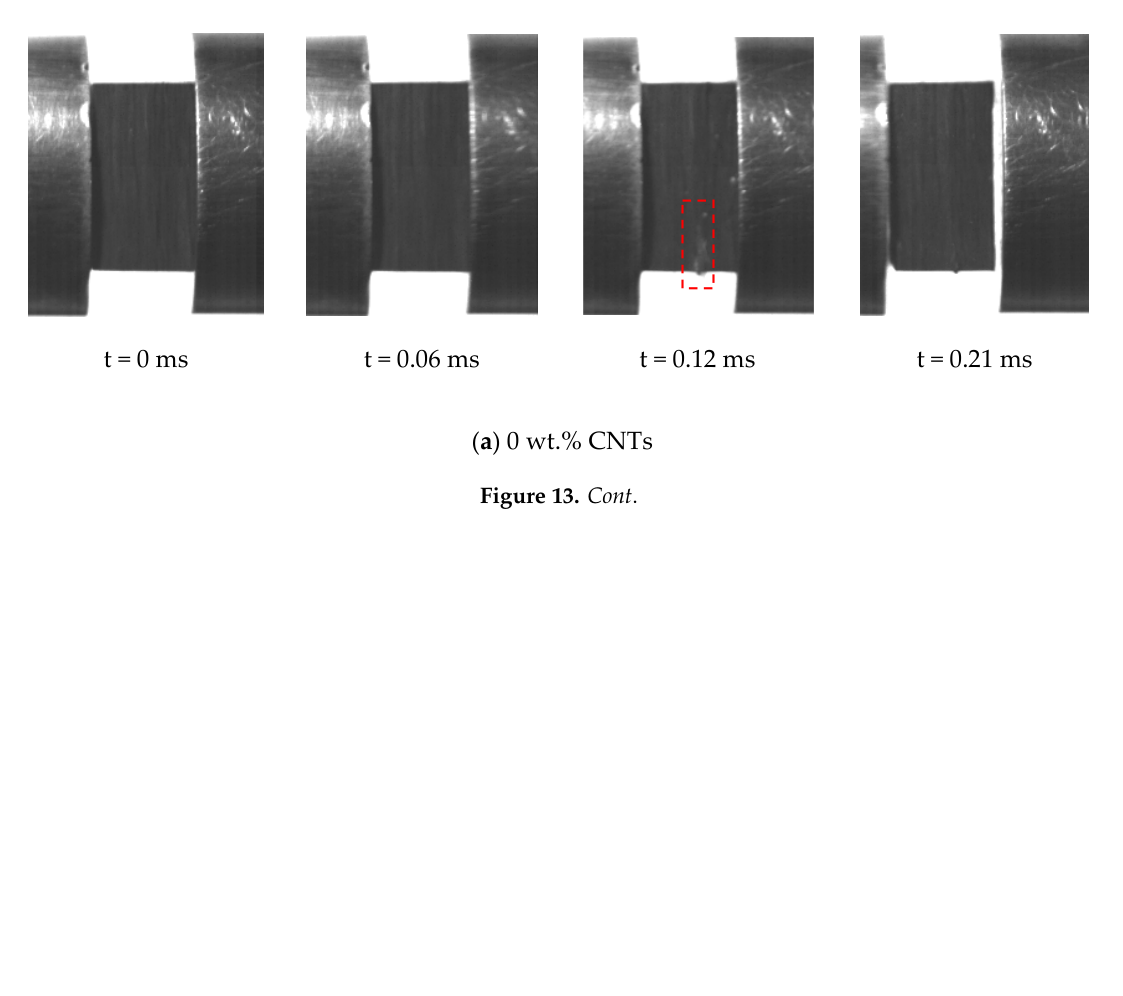
Figure 12. Evolution of the stress and strain rate vs time curves for different mass fraction, P = 4 bar.